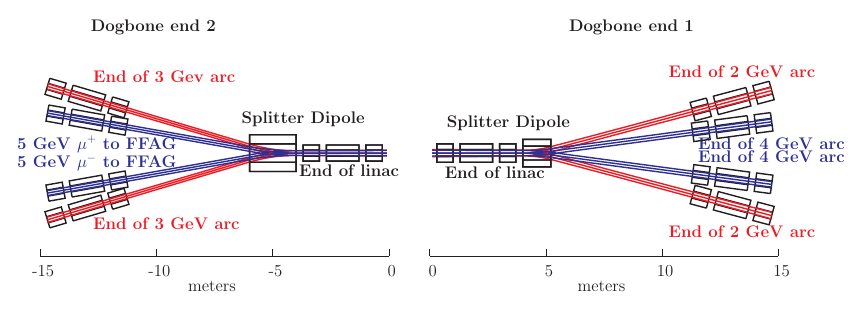
FIG. 24. (Color) Dog-bone RLA Switch Yards.